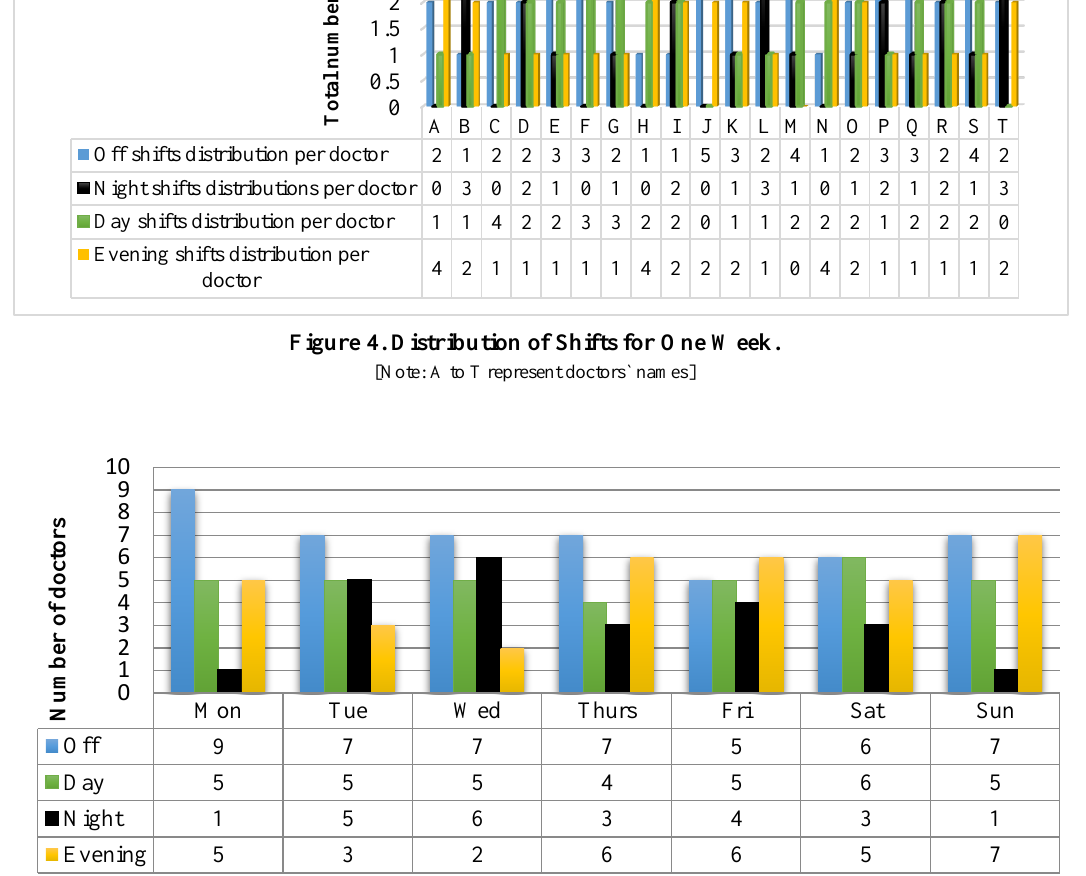
Figure 5. Weekly Assignments of Shifts Per Day of the